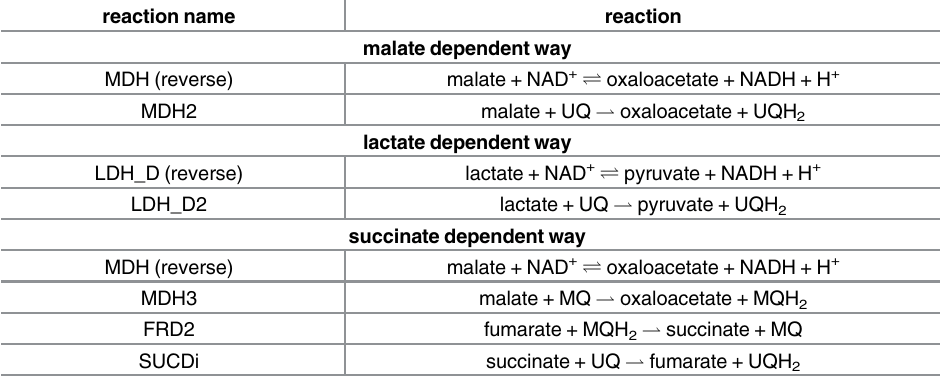
Table 2. Alternative pathways for reoxidation of